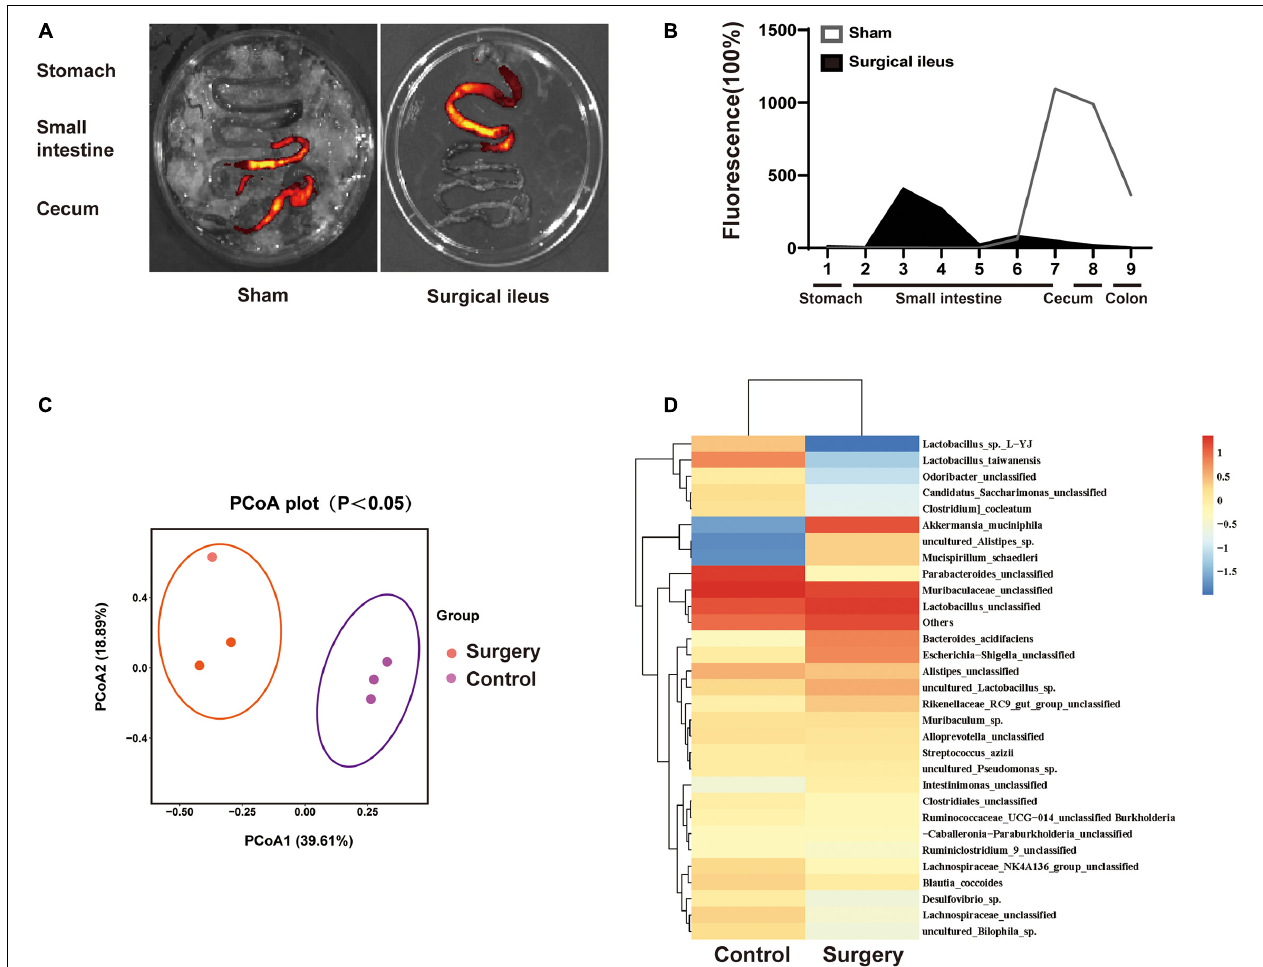
FIGURE 7 | Intestinal motility dysfunction and change in gut microbiota composition after intestinal paralysis. (A) Intestinal motility was measure 3 days after control and surgery ileus mice. (B) Representative fluorescence images of the complete gastrointestinal tract 1 h after gastric instillation of FITC-dextran showing retention of the fluorescence intensity in intensity segments after intestinal paralysis ( n = 3 per group). (C) Principal coordinates analysis of the gut microbiota composition in control and intestinal paralysis in ICH mice after 3 days ( n = 3 per group). (D) Heat maps of the cluster analysis showing gut microbiota composition in control and intestinal paralysis after 3 days mice ( n = 3 per